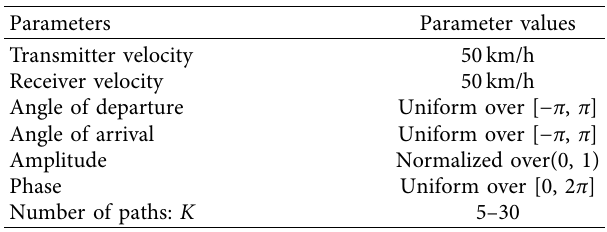
Table 1: Simulation parameters.